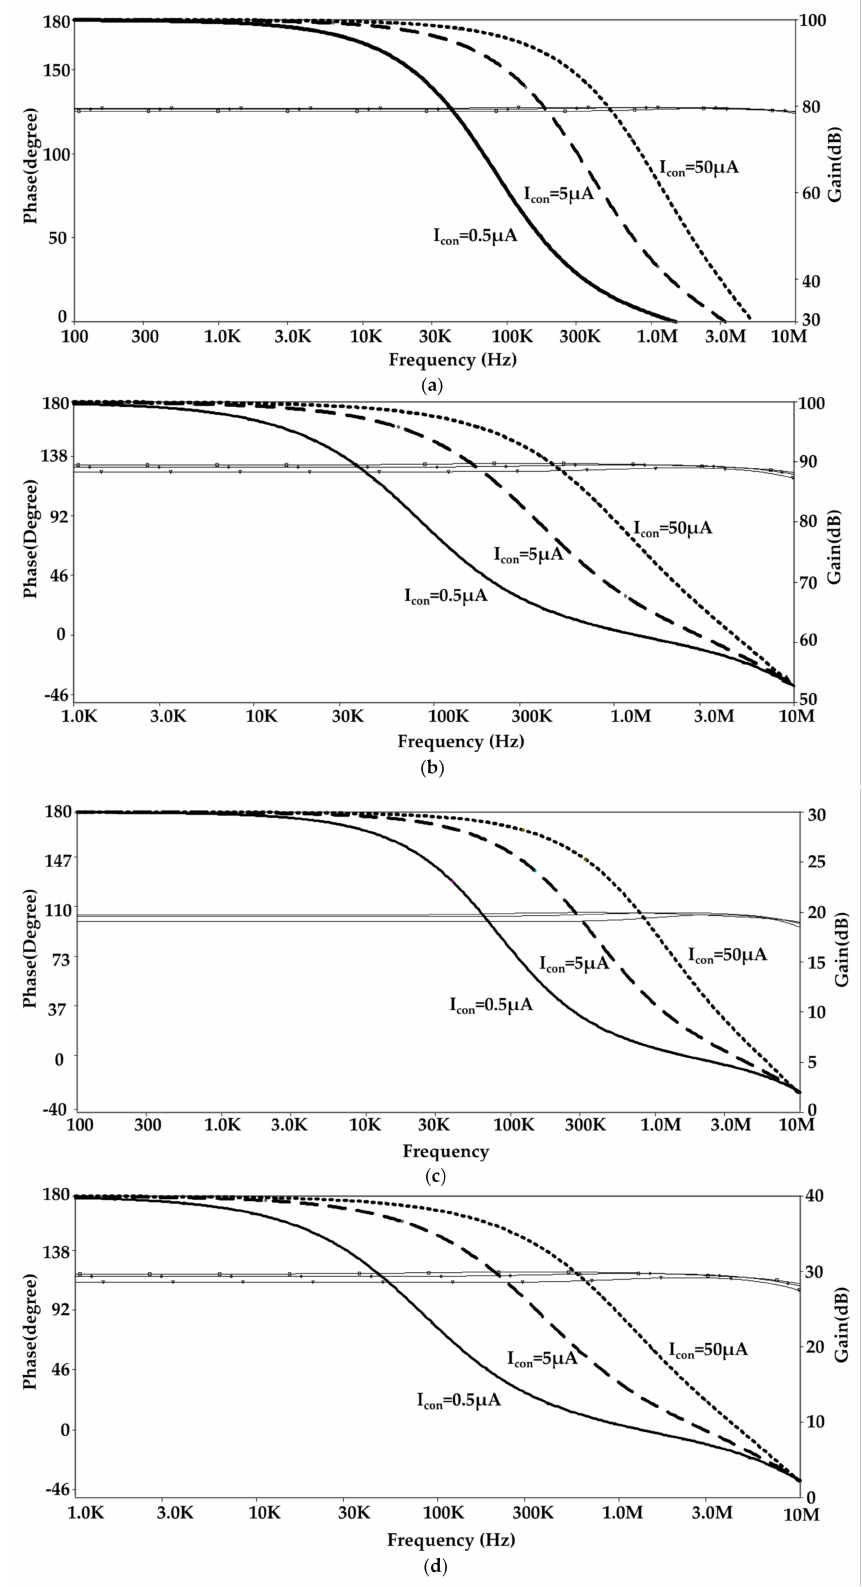
Figure 10. Gain and phase frequency response of ( a ) V AP for V con = 0 V, ( b ) V AP for V con = − 0.9 V, ( c ) I AP for V con = 0 and ( d ) I AP for V con = − 0.9